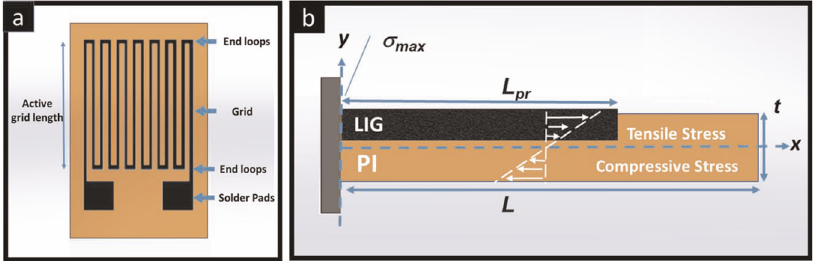
Fig. 9 a LIG electrodes (black) patterned on a fl exible polyimide sheet (orange). b Schematic of a cross-section of piezoresistive cantilever